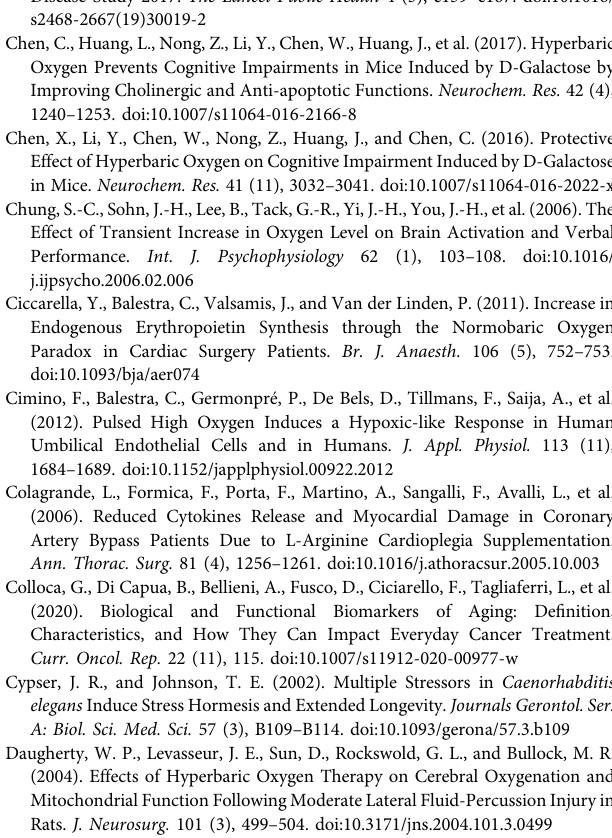
Supplementary Table S3 | The effect of hyperoxia on aging markers in rats. Supplementary Table S4 | The effect of hyperoxia on aging markers in insects and